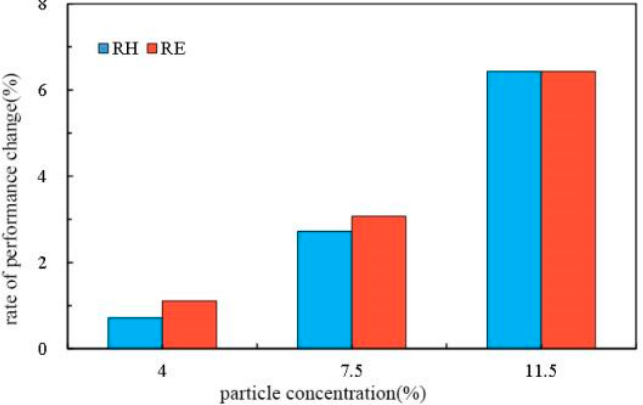
Figure 10. Influence of different particle concentrations on pump performance.